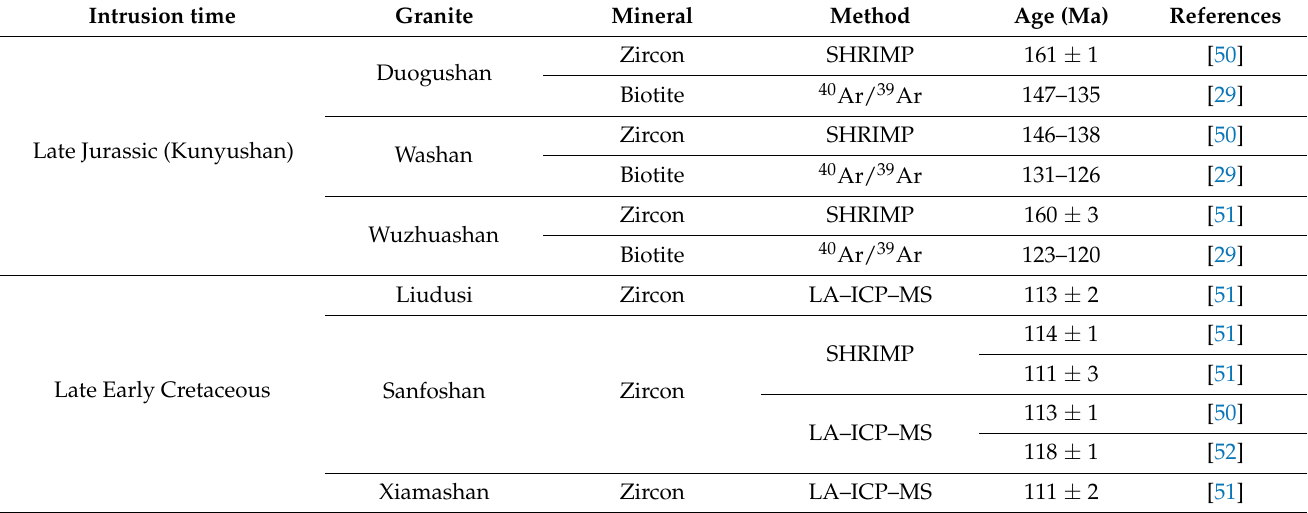
Table 1. Age of the wallrock in the Muping–Rushan gold